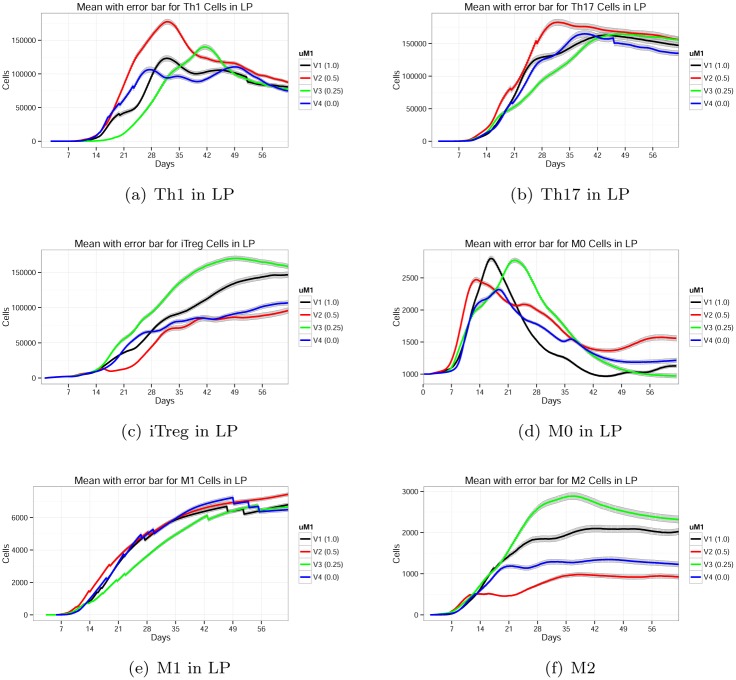
Effect of parameter μ
M1 on Th1, Th17, iTreg, M0, M1, and M2 phenotypes.